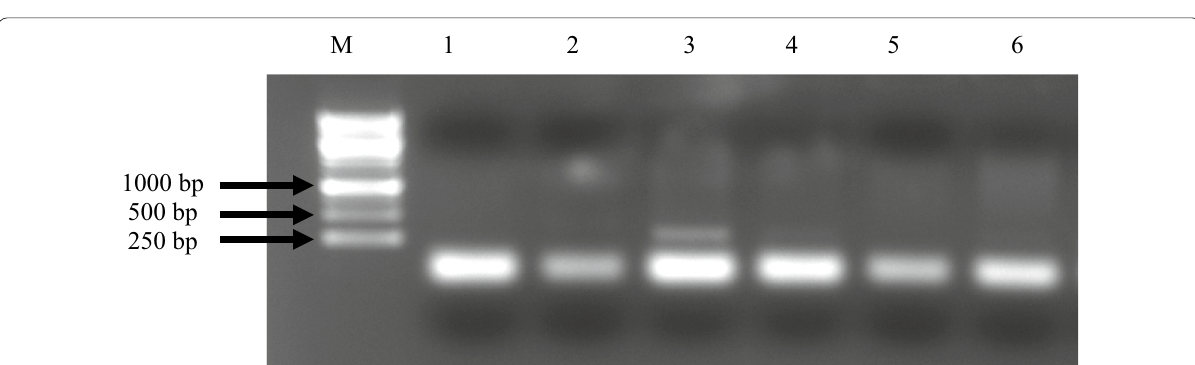
Fig. 3 PCR amplicon of mtx 1 toxin genes of all bacteria. 1: GV1, 2: GV3, 3: GV4, 4: GV5, 5: GV6, 6: GV7. Bacillus mycoides (Lane 3: the size of band is approximately 300